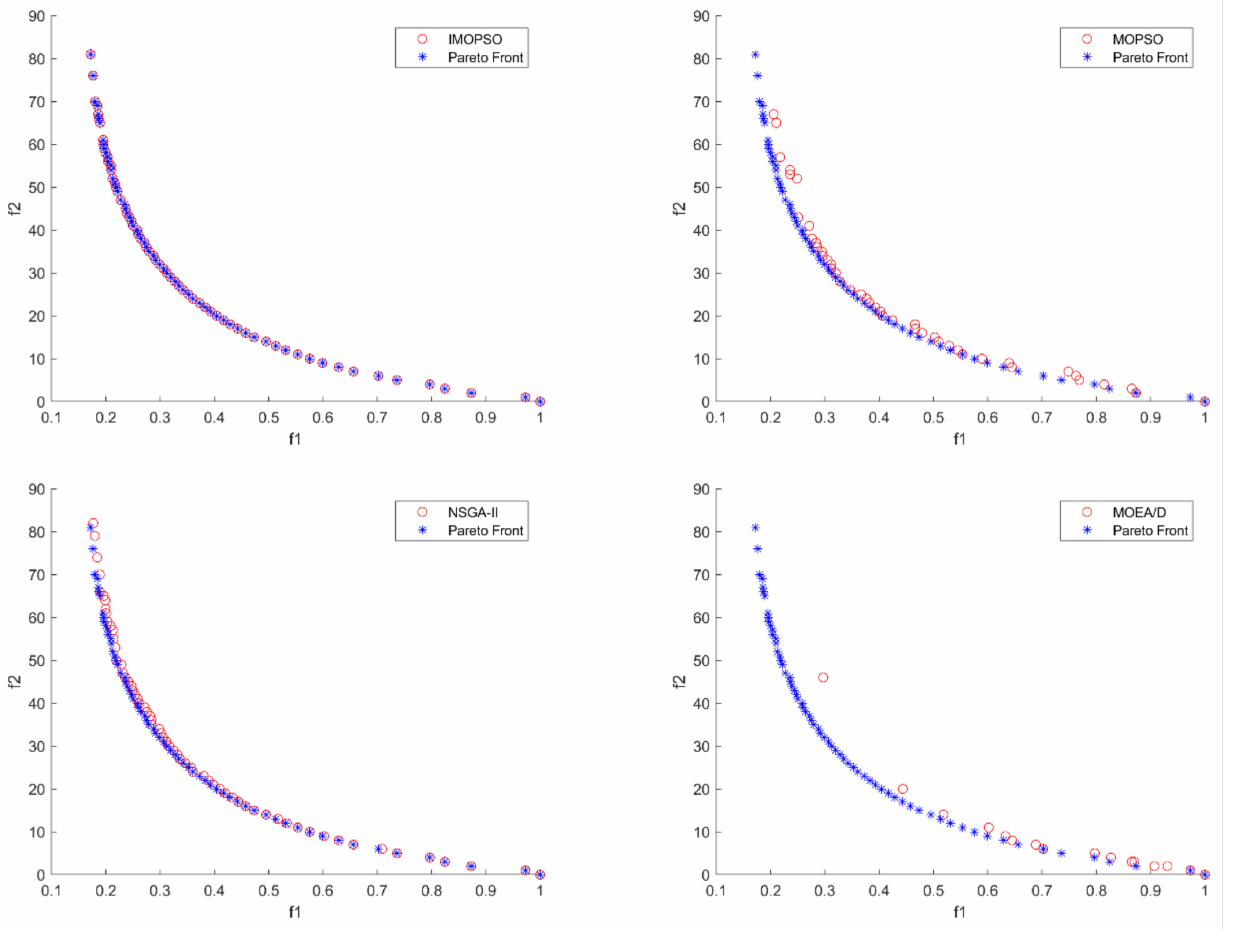
Figure 13. Pareto front produced by four algorithms on small-scaled